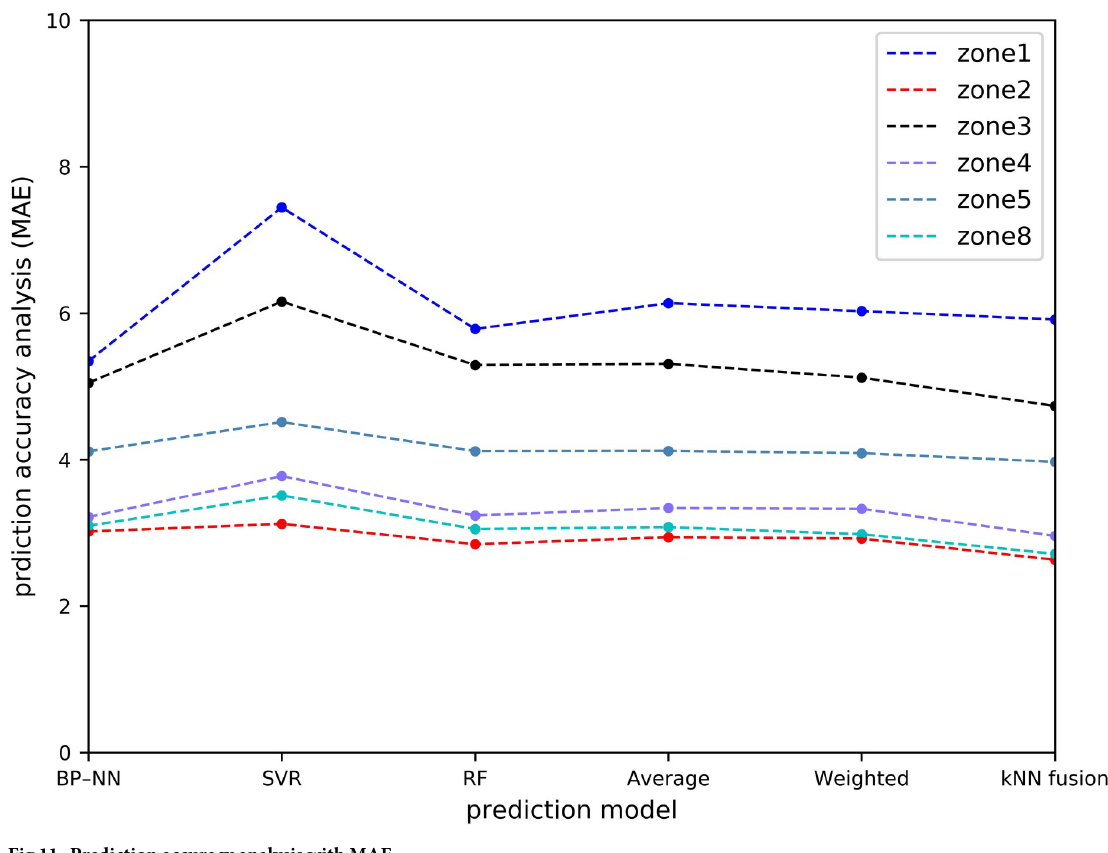
Fig 11. Prediction accuracy analysis with